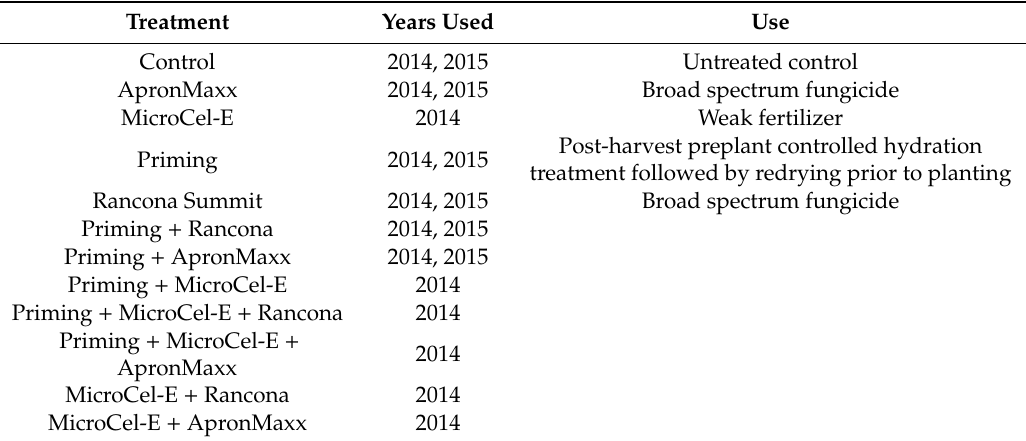
Table 2. Seed treatments used in this